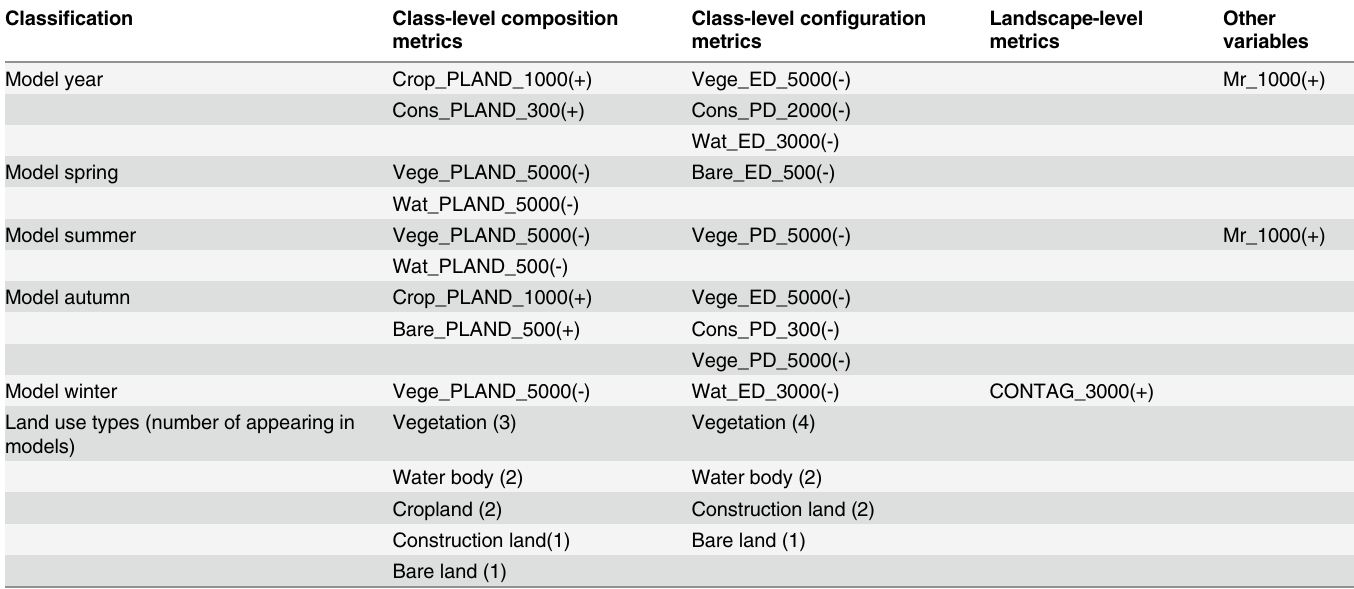
Table 5. Classification of independent variables included in regression